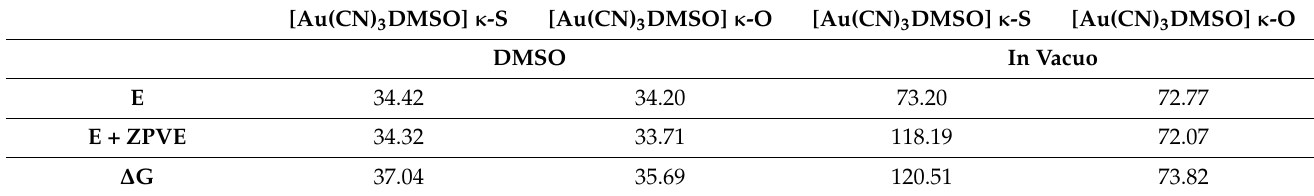
Table 3. Energy (E); energy corrected by the zero-point vibrational energy (E + ZPVE); Gibbs free energy ( ∆ G) of the complex formation of gold(III) tricyanide dimethyl sulfide complex. In vacuo—results obtained without solvation. DMSO—results obtained using PCM implicit solvation model. All values are in